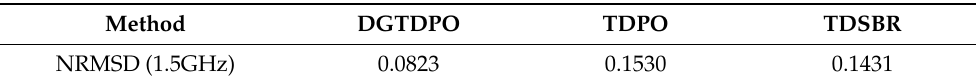
Table 4. The NRMSD of DGTDPO, TDPO and TDSBR for multi scale-plate composite objects at 1.5 GHz. Method